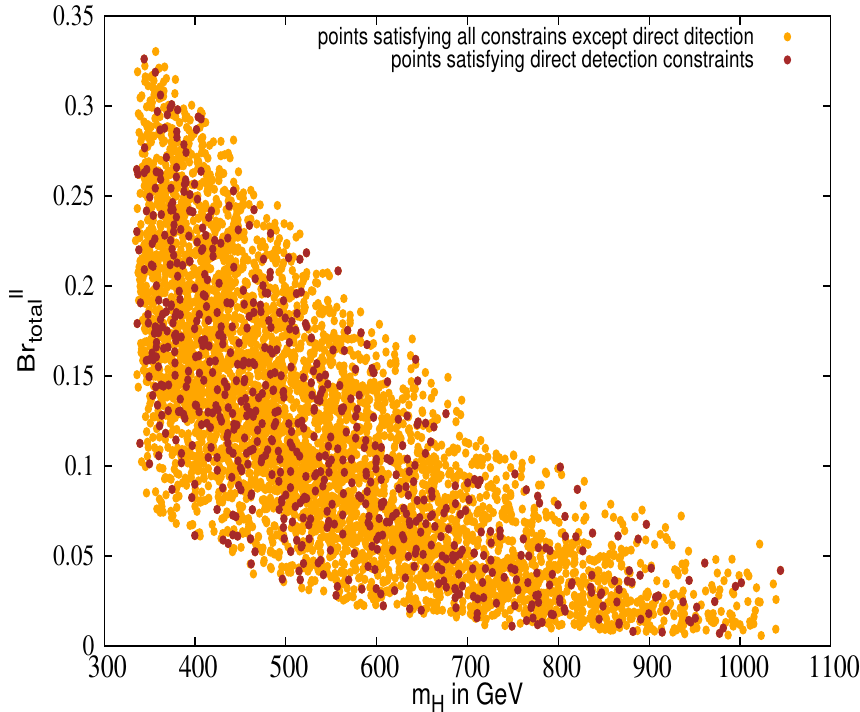
Figure 7 . m H distribution of Br ‘‘ . Orange points satisfy only relic density bounds and over total and above that the brown points satisfy the current direct detection limit coming from